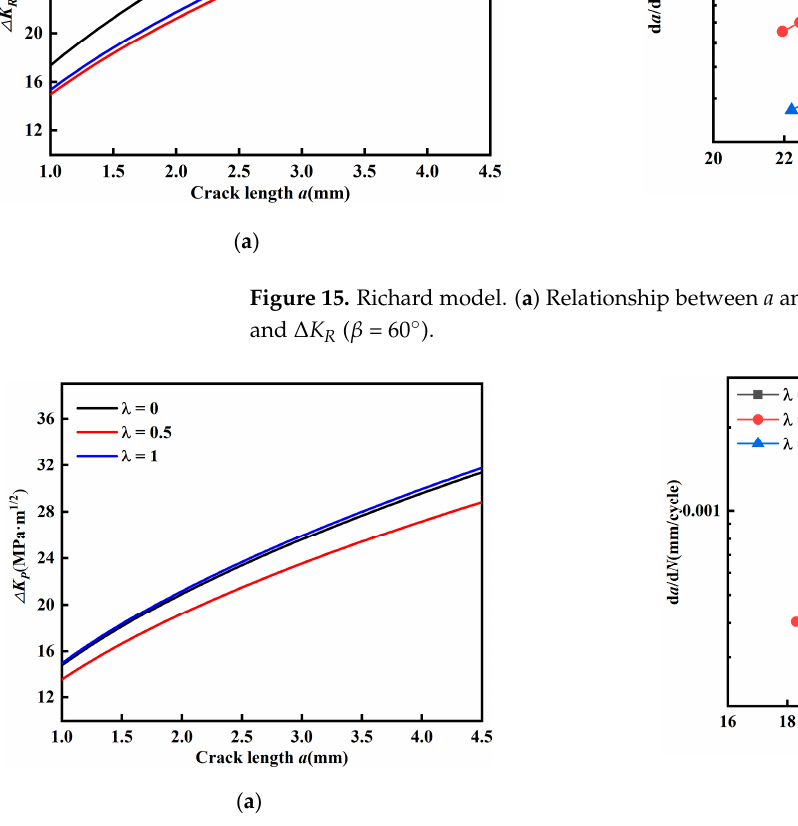
Figure 16. Pook model. ( a ) Relationship between a and △ K R ( β = 45°). ( b ) Relationship between a and △ K R ( β = 45°).